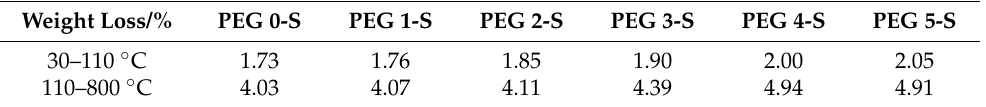
Figure 1. Fourier transform infrared spectroscopy (FTIR) spectroscopy of modified silica. Table 3. Weight losses of modified silica.